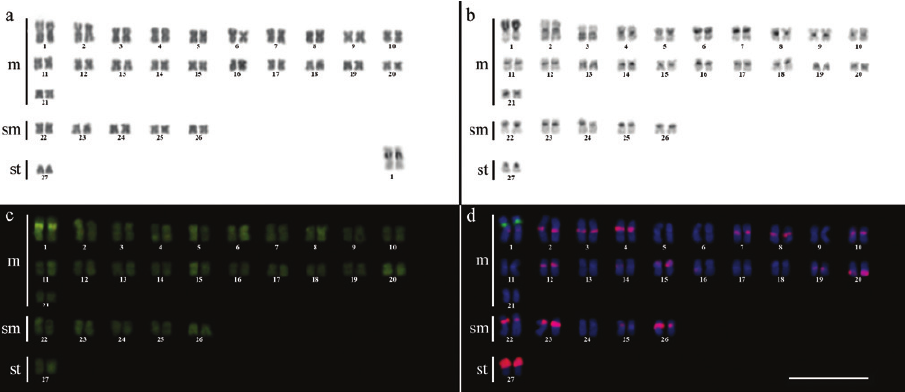
Figure 3a–d. Karyotype of G . inaequilabiatus after ( a ) conventional Giemsa staining, ( b ) C-banding, ( c ) CMA fluorochrome staining, ( d ) double FISH with 5S rDNA (red) and 18S rDNA (green) probes. 3 Bar =